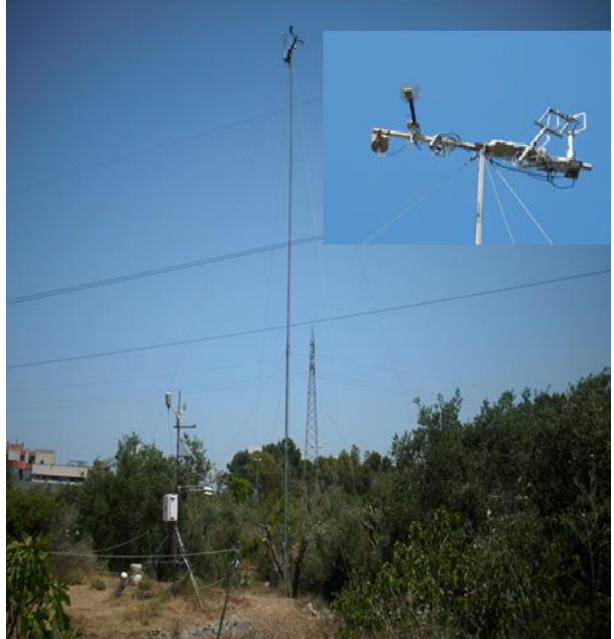
Figure 1. The CNR-ISAC (Consiglio Nazionale delle Ricerche, Istituto di Scienze dell’Atmosfera e del Clima) micrometeorological base; the telescopic mast with a particular of the e.c. instrumentation on top-right, where the Krypton Kh20 hygrometer and the Gill ultrasonic anemometer are visible at the extreme right; the ancillary campbell station collecting the soil data is visible at the bottom left (see also Section 3).